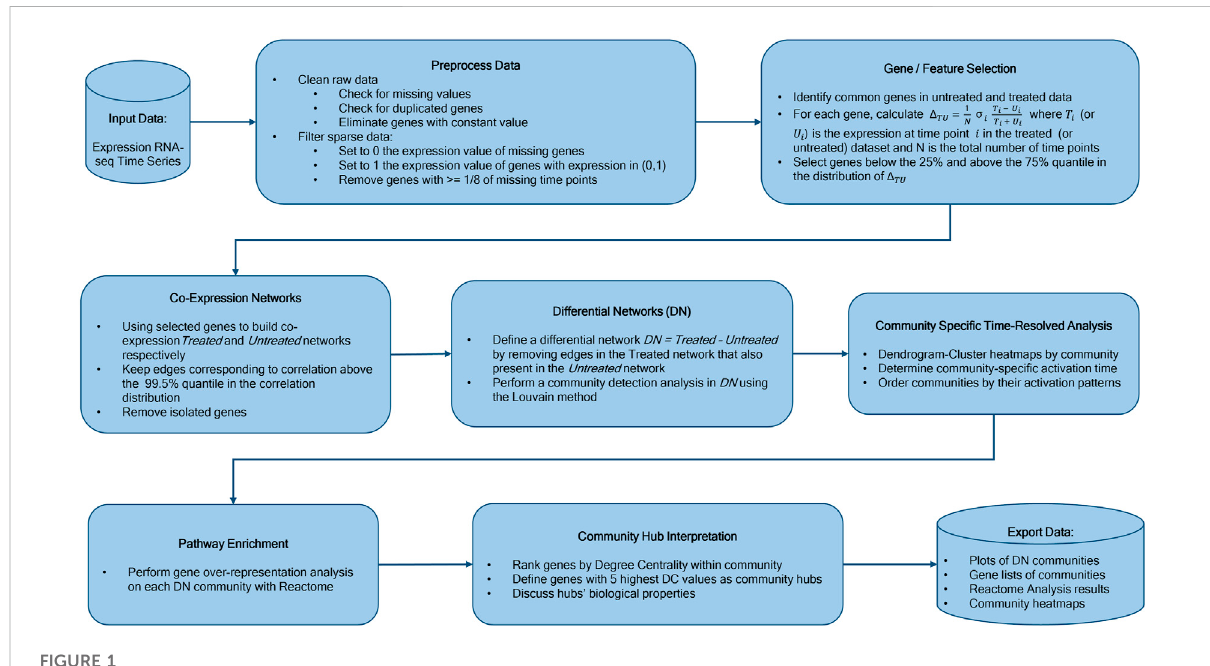
FIGURE 1 Work fl ow Overview. Our methodology starts with time course experimental data, followed by network construction, differential network determination, community detection, sequential ordering by activation pattern, pathway analyses of individual communities, community hub gene interpretation, and fi nal results including analyses and temporal trend